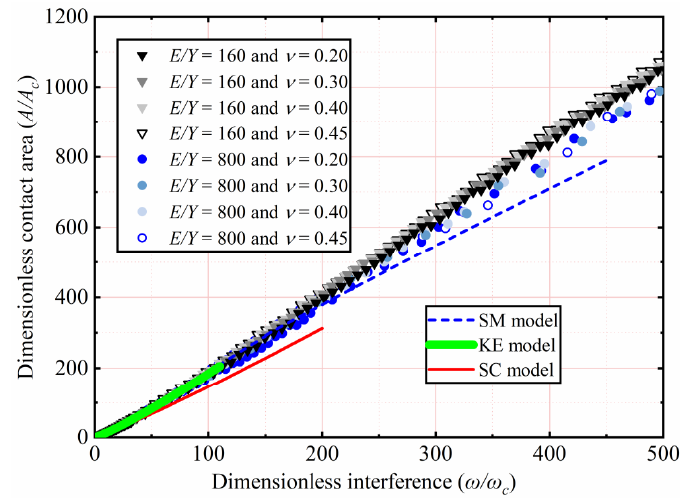
Table 6. Parameters in Equation (12).